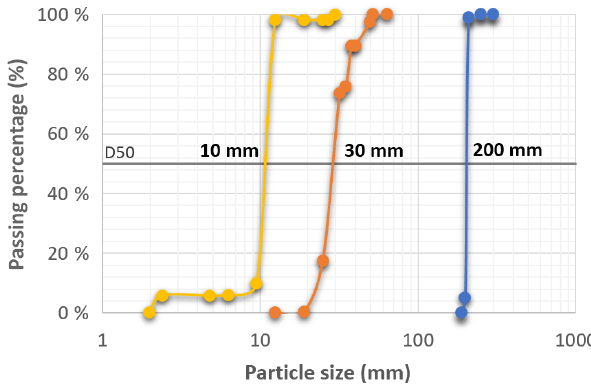
Figure 2. Particle size distribution of the rice straw mulch used in the experiments. D50 is used in the text as a reference for the 10, 30 and 200mm mulch